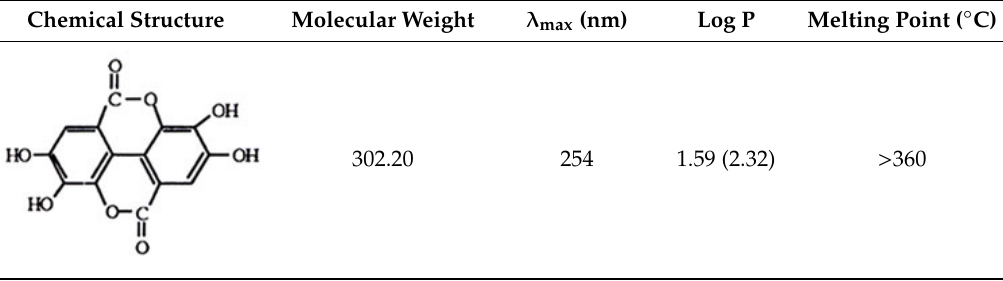
Table 1. Chemical structure and some physicochemical characteristics of ellagic acid (EA).